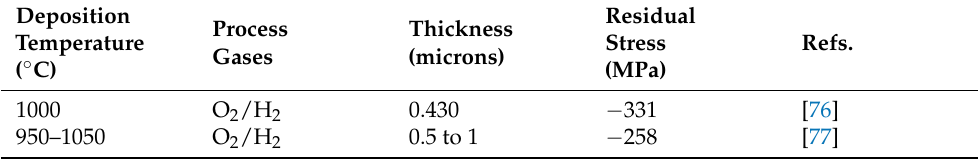
Table 1. Residual stresses measured in silicon dioxide layers grown using wet thermal oxidation.